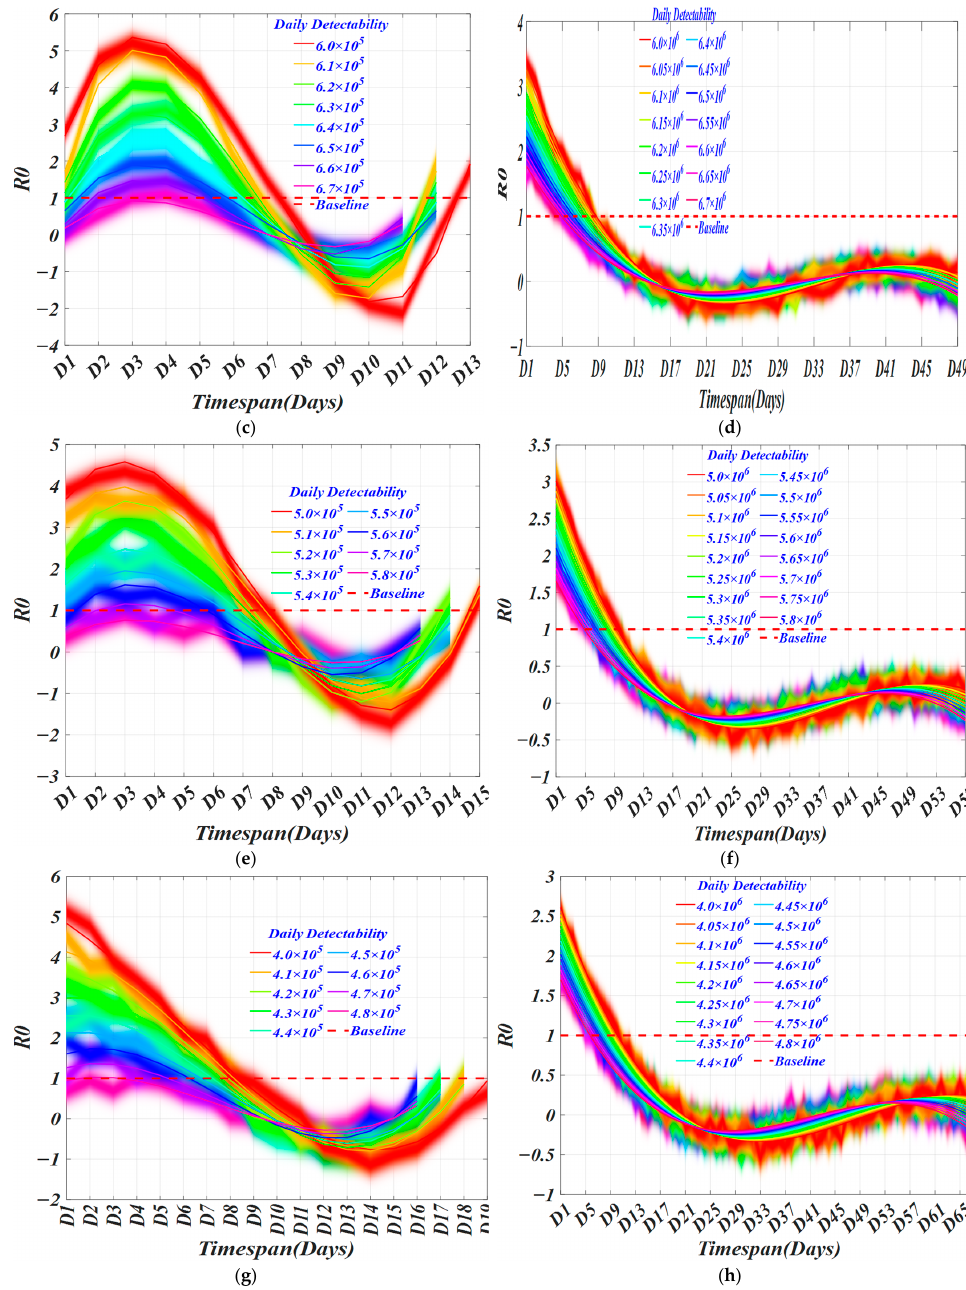
Figure 6. The R0 of different daily detectability changes over time. ( a ) The daily detectability from 700,000 cases to 750,000 cases with an interval of 10,000 cases in HK; ( b ) The daily detectability between [7,000,000 cases 7,500,000 cases] with an interval of 50,000 in US; ( c ) The daily detectability between [600,000 cases 670,000 cases] with an interval of 10,000 in HK; ( d ) The daily detectability between [6,000,000 cases 6,700,000 cases] with an interval of 50,000 in US; ( e ) The daily detectability between [500,000 cases 580,000 cases] with an interval of 10,000 in HK; ( f ) The daily detectability between [5,000,000 cases 5,800,000 cases] with an interval of 50,000 in US; ( g ) The daily detectability between [400,000 cases 480,000 cases] with an interval of 10,000 in HK; ( h ) The daily detectability between [4,000,000 cases 4,800,000 cases] with an interval of 50,000 in US. In Table 8, two optimal strategies are obtained, and the results of the average most effective screening strategy are calculated. The screening timespan of the first optimized screening strategy is 8 days in HK and 9.5 days in the U.S. The daily detection